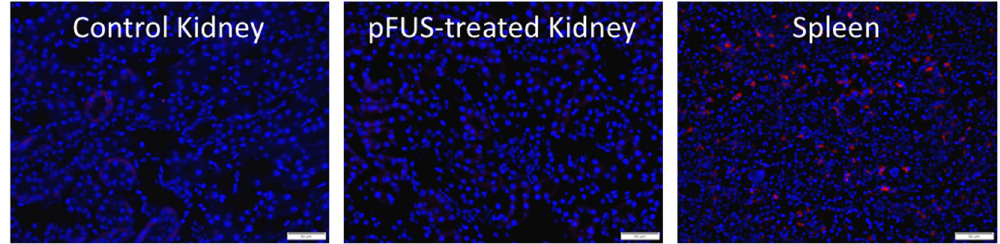
Figure 2. pFUS does not stimulate macrophage infiltration by 3 days post-pFUS. Mice were given fluorescently labeled SPION to label splenic macrophages 3 days before pFUS to kidneys. Mice were euthanized 3 days after pFUS. Treated and control kidneys were imaged and revealed rare incidences of SPION signal. For positive control, a spleen harvested 3 days post-pFUS demonstrates SPION fluorescence. Scale bars = 50 μ